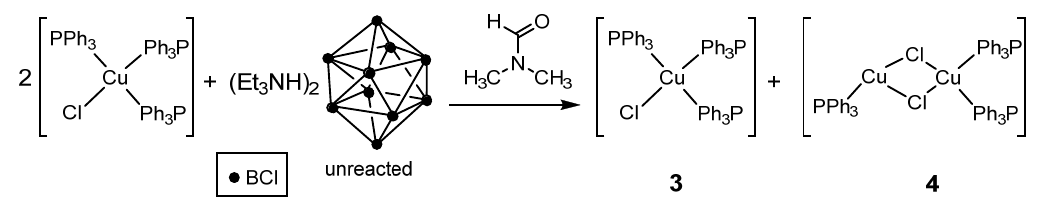
thermal ellipsoids ( p = 50%). For both solids only half of the anion is symmetrically